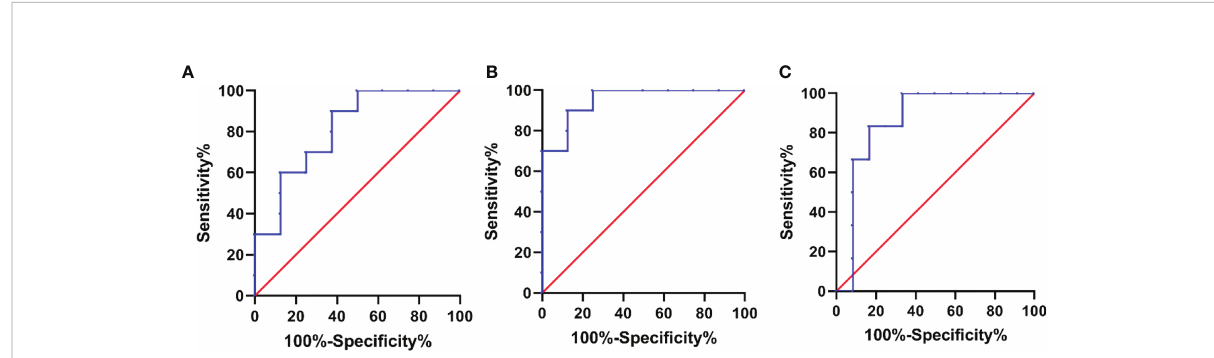
FIGURE 4 Receiver operating characteristic (ROC) curve of cytokines for predicting reteral involvement in IRPF. (A) Based on bilateral ureteral dilatation, the area under the ROC curve (AUC) of IL-10 was 0.813, sensitivity 0.900 and speci fi city 0.625. (B) Based on bilateral ureteral dilatation, the AUC of TNF- a was 0.950, sensitivity 0.900 and speci fi city 0.875. (C) Based on bilateral ureteral obstruction, the AUC of IL-6 was 0.861, sensitivity 0.833 and speci fi city 0.833.